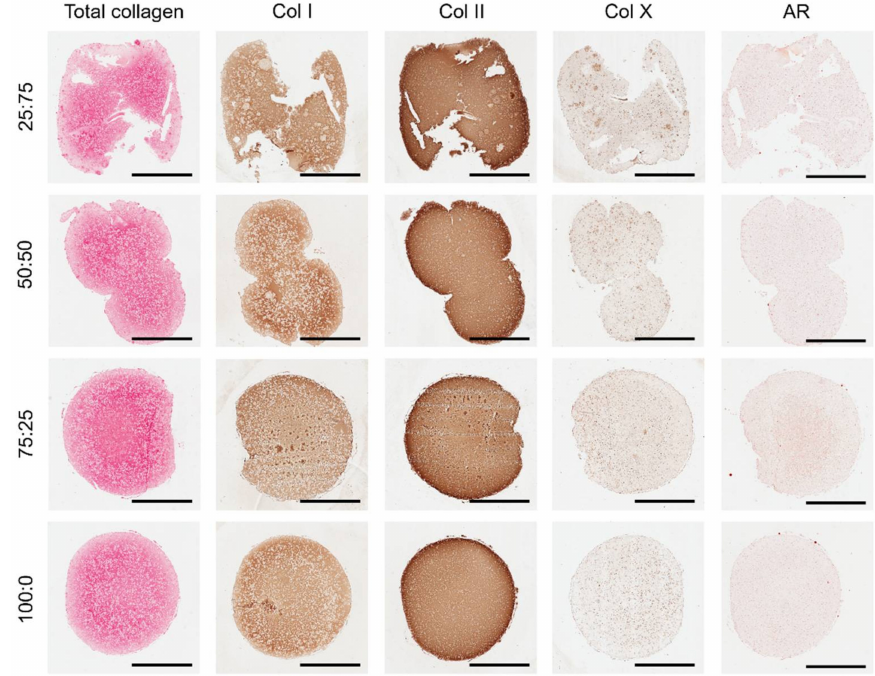
Figure 5. Histological evaluation. Picrosirius red staining for total collagen. Immunohistochemical staining for collagen types I, II, and X. Alizaring red (AR) staining for calcium deposits. Scale bars are equal to 2